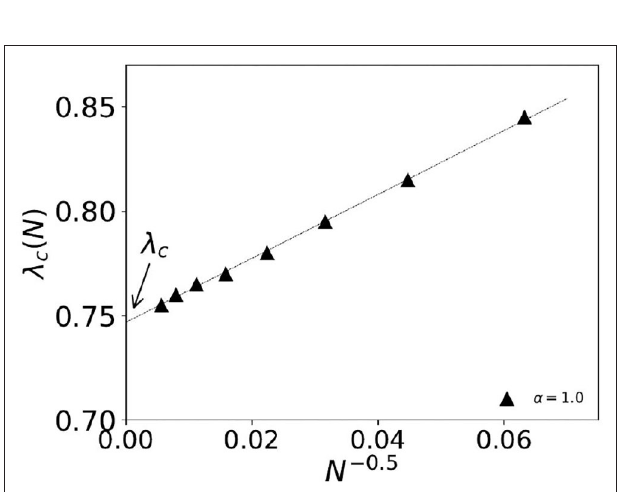
f ) and convergence time τ against customer − f ) 1λ β where β 1λ − γ where γ λ λ c ( N ) 1.0 0.02 and τ 0.5 0.02. Here, 1λ . The insets show the variation − ∼ = ± ∼ = ± ≡ | − | λ c ( N ). (A) for N 16,000 and (B) for N 32,000. = = =